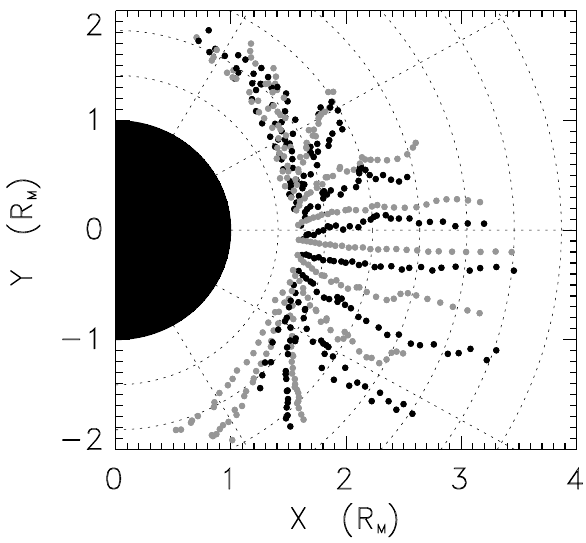
Fig. 5. Na + trajectory apex in the X − Y plane for different initial longitudes and latitudes in the dayside sector. The apexes obtained for 18 = 10kV and 18 = 30kV are coded in grey and black, re- spectively. Dotted lines show longitudes and altitudes by steps of